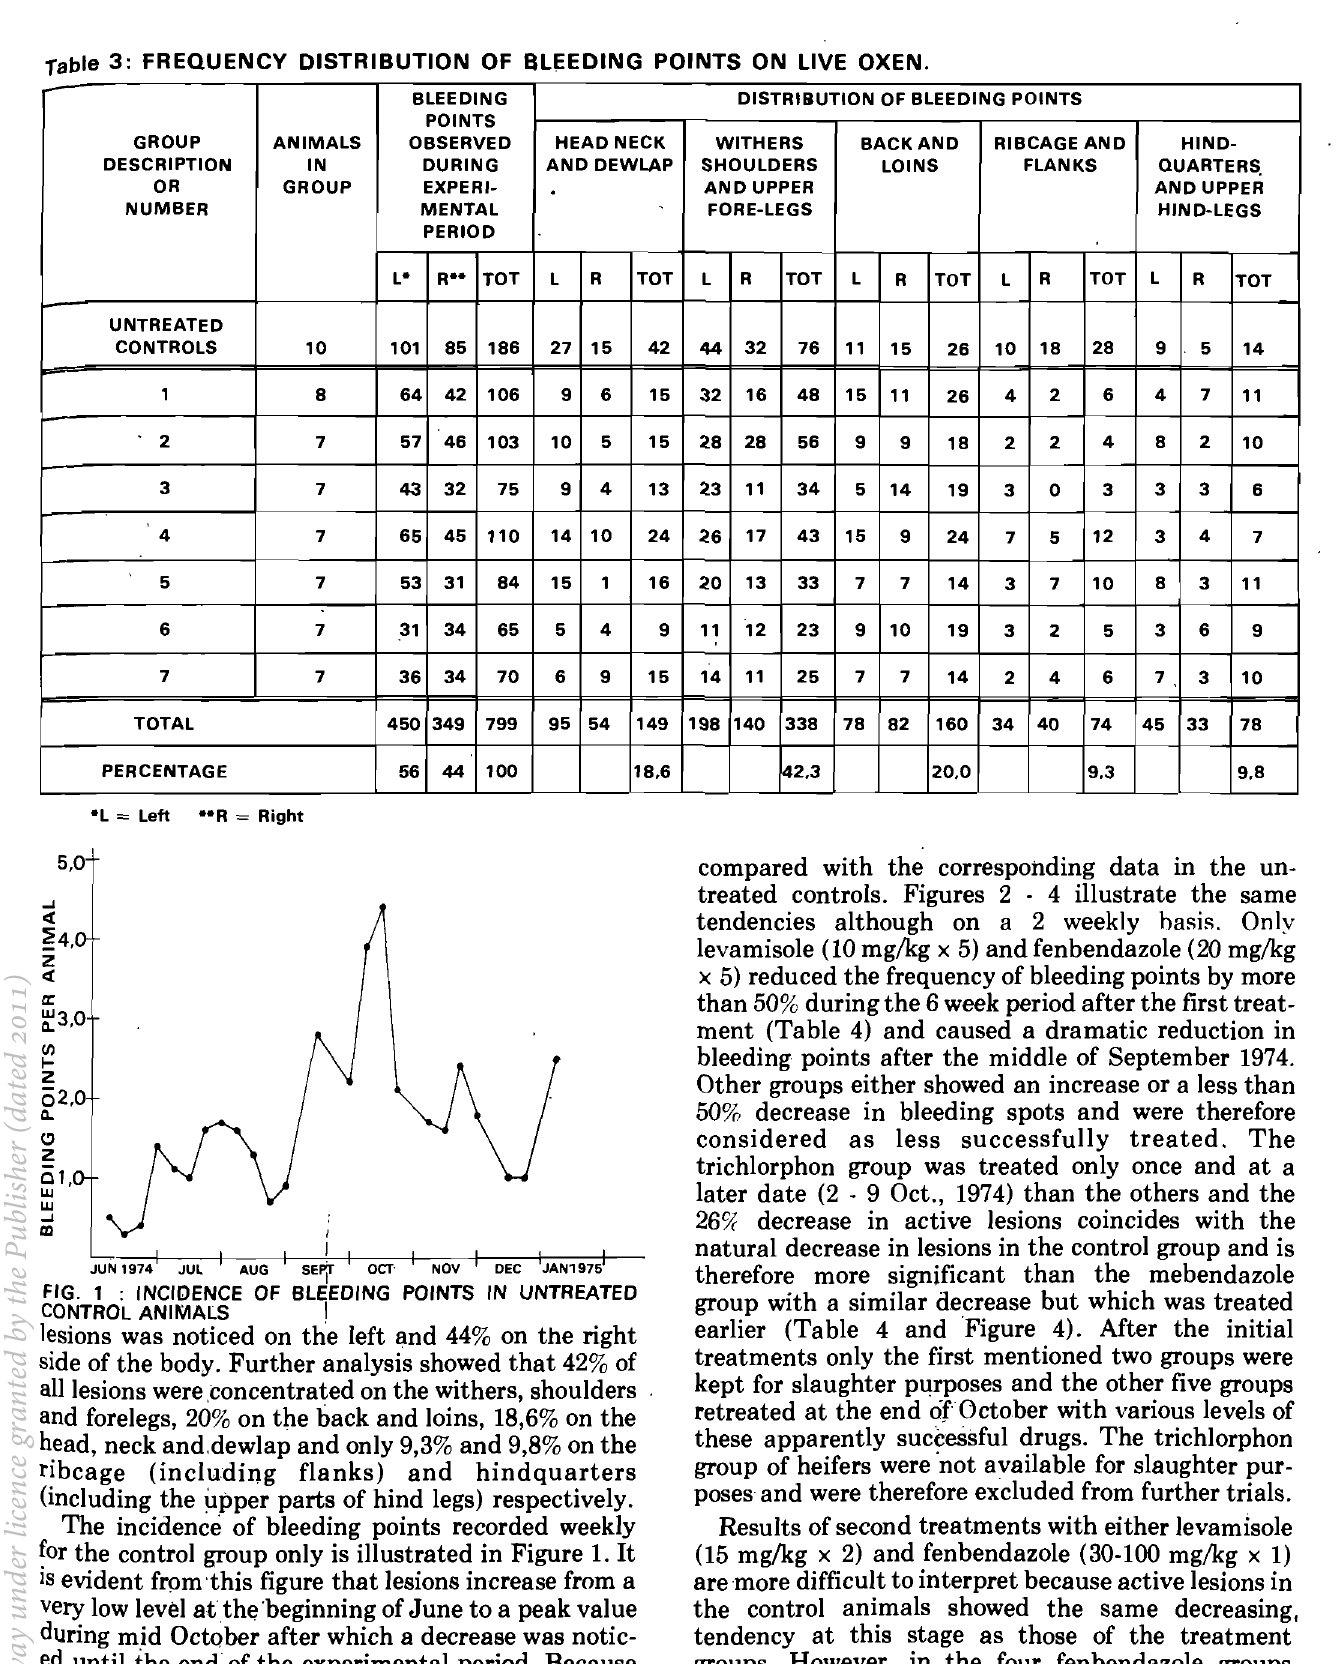
Table 3: FREQUENCY DISTRIBUTION OF BLEEDING POINTS ON LIVE OXEN.